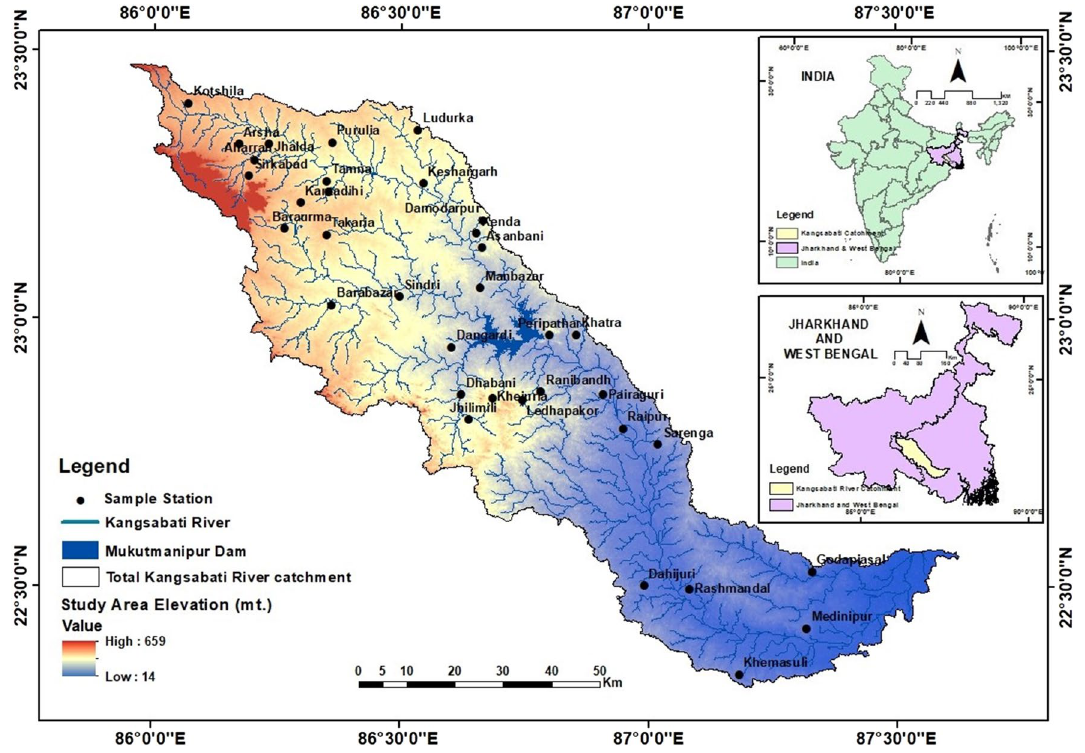
Fig. 1 Location map of the study area showing the sampling points and drainage network of Kangsabati River